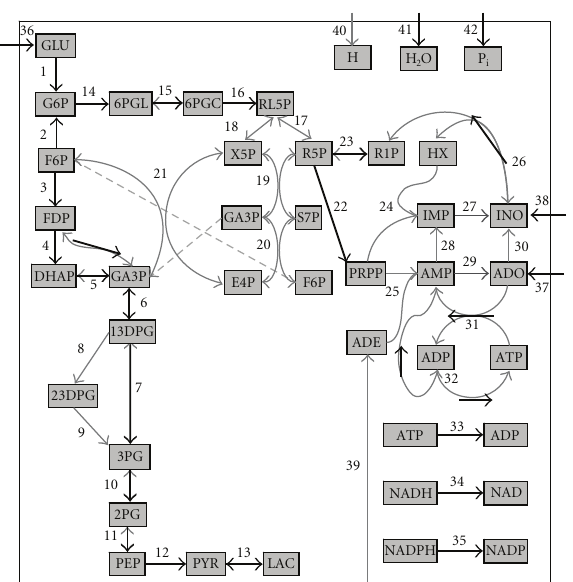
Figure 6: Large overlap backbone of hRBC: thick black arrows mark reactions with an overlap larger than 0.9 in an optimal healthy